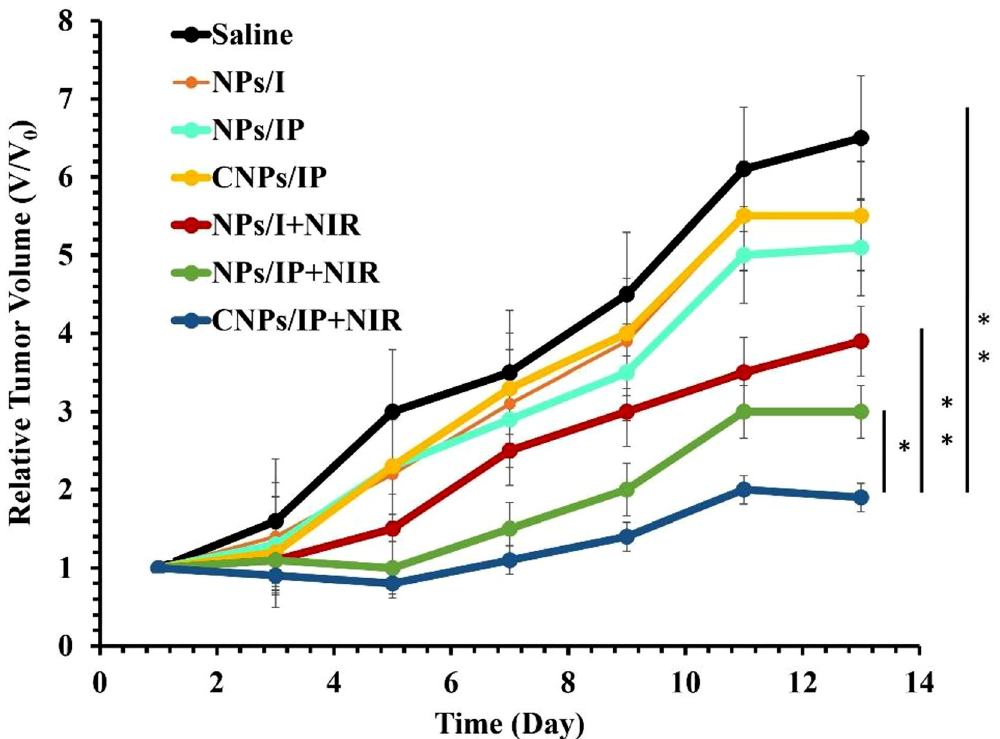
Figure 8: Tumor growth curves in mice treated in vivo on an MDA-MB-231 tumor model with saline solution, NPs/I with or without laser irradiation, NPs/IP with or without laser irradiation, and CNPs/IP with or without laser irradiation. The values are expressed as mean ± SD, ( n = 5, * P < 0.01, ** P < 0.005, Student ’ s t -test). After24h,thetumorsinlasertreatedgroupswereirradiatedbyan808nmlaserwithapowerof2Wcm − 2 for20s. I =IR780, P =Per fl uorooctyl bromide (PFOB), NPs = PEG-PCL (polyethylene glycol-poly ( α -caprolactone)), C = CRGDK, V 0 = Initial tumoral volume before treatment